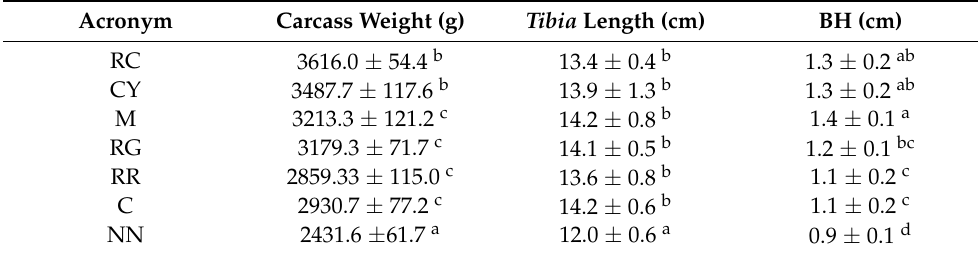
Table 2. Carcass weight (mean ± S.D.), length of the tibia (mean ± S.D.), and width of the arch (BH, mean ± S.D.) of the six genetic lines and of naked neck (NN). Different letters indicate significant differences among treatments (Tuckey test; p < 0.05); similar letters depict no significant